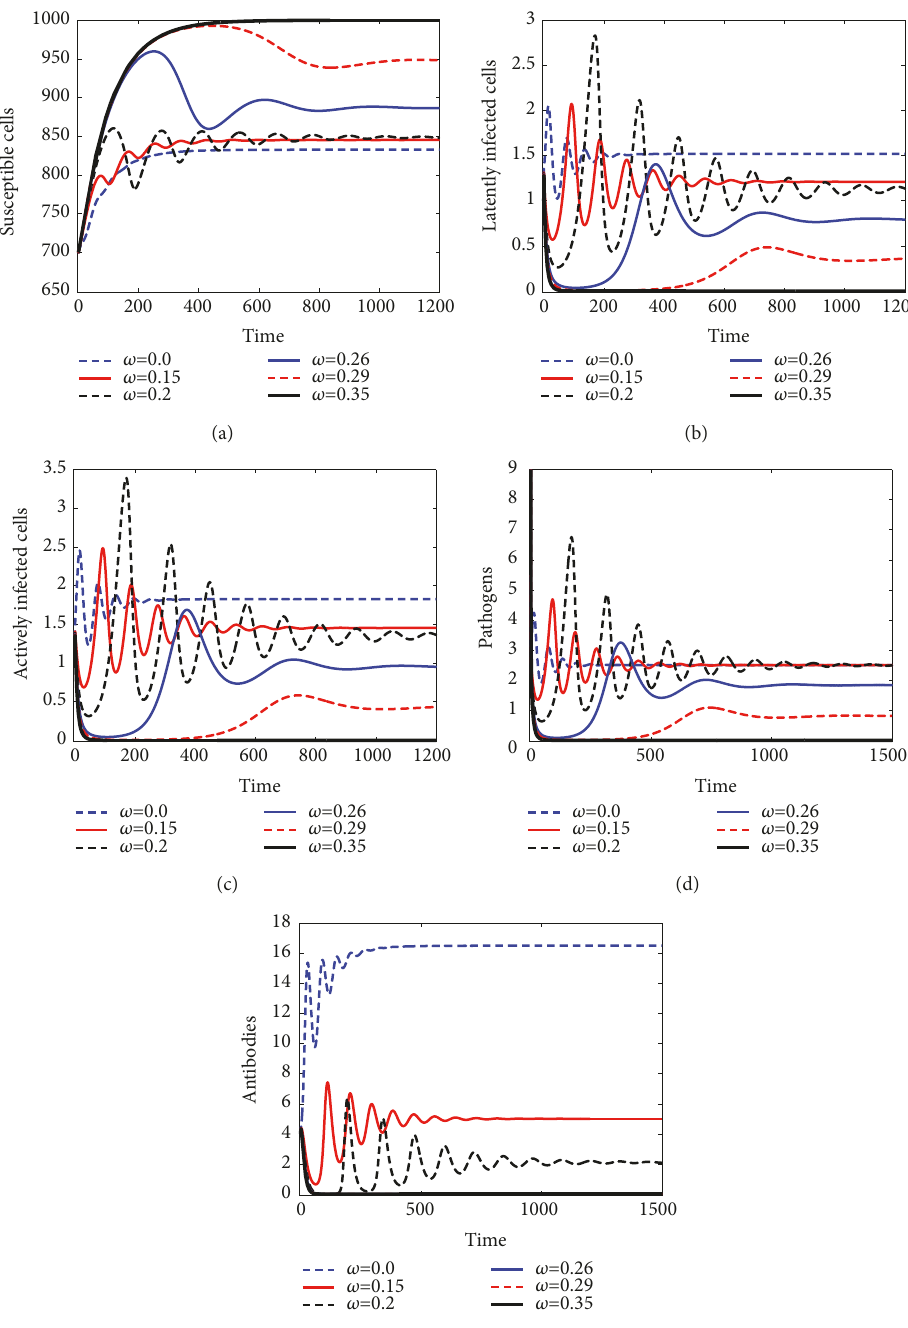
Figure 3: The evolution of system (69)-(73) with different values of 𝜔 for Case